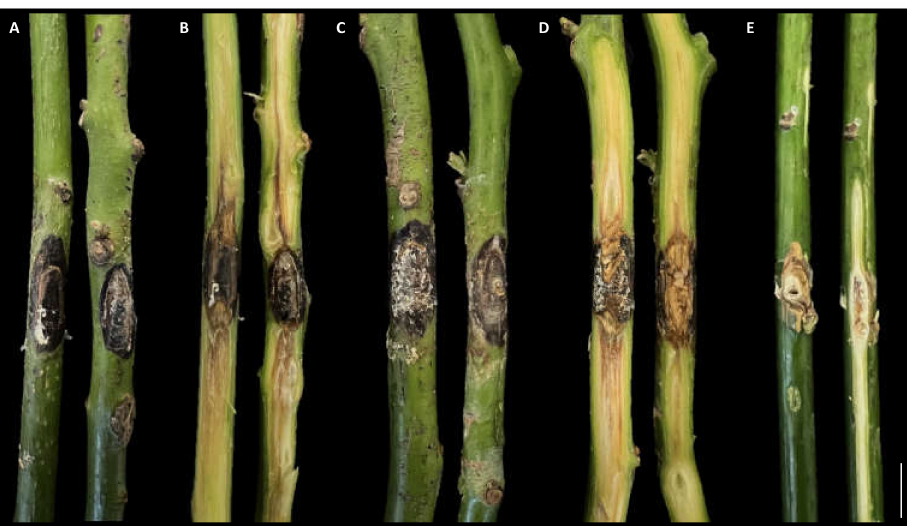
Figure 5. Results of pathogenicity test after 50 days. ( A , B ) External and internal lesions caused by Neopestalotiopsis rosae ; ( C , D ) external and internal lesions caused by N. siciliana ; ( E ) control. Scale bar = 2 cm.